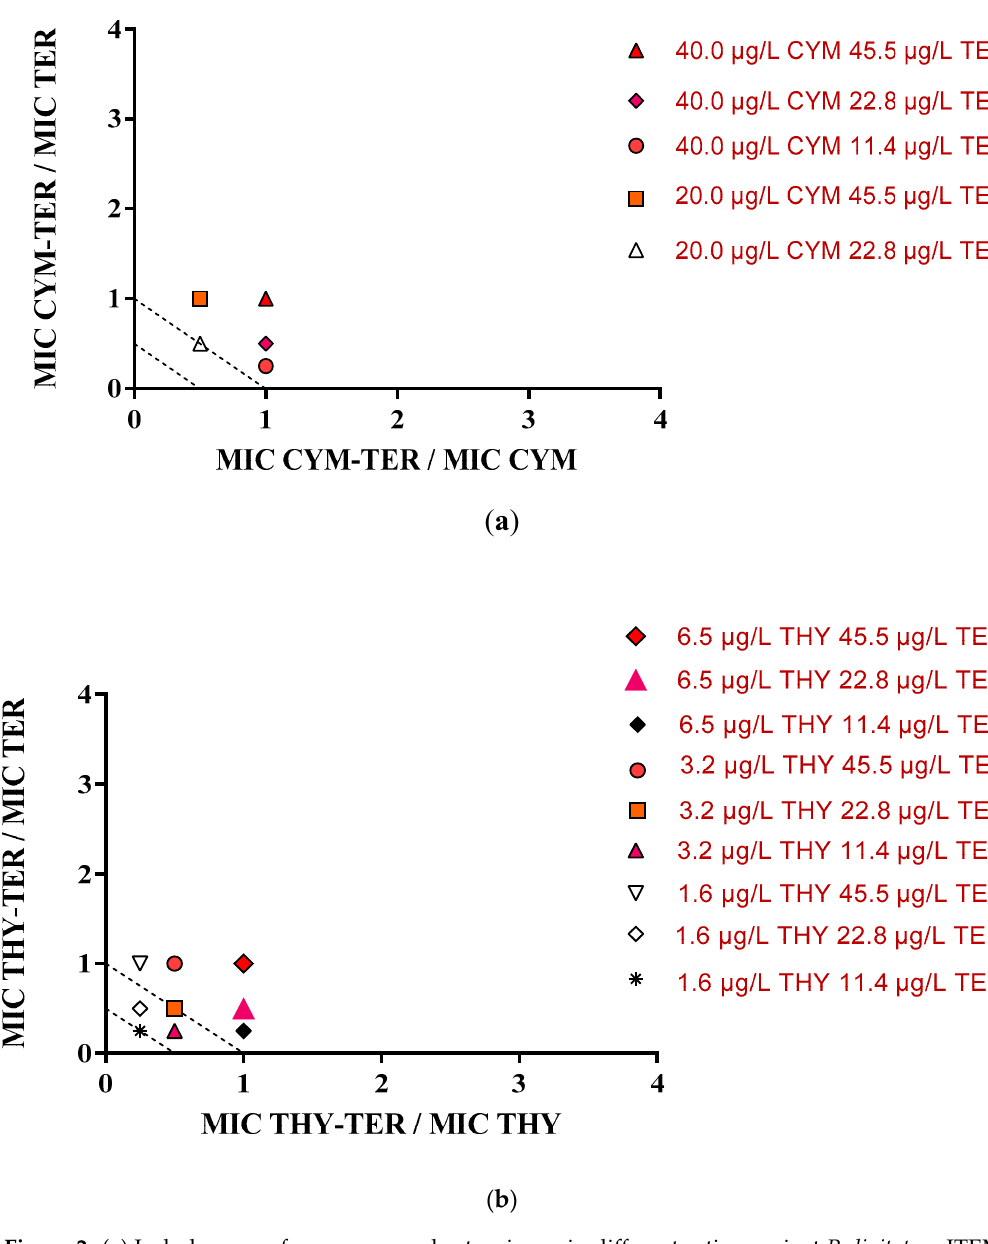
Figure 2. ( a ) Isobologram of p-cymene and γ -terpinene in different ratios against P. digitatum ITEM 9569; ( b ) isobologram of thymol and γ -terpinene in different ratios against P. digitatum ITEM 9569. In this case, the fractional inhibitory concentration (FIC) values are reported on each axis.